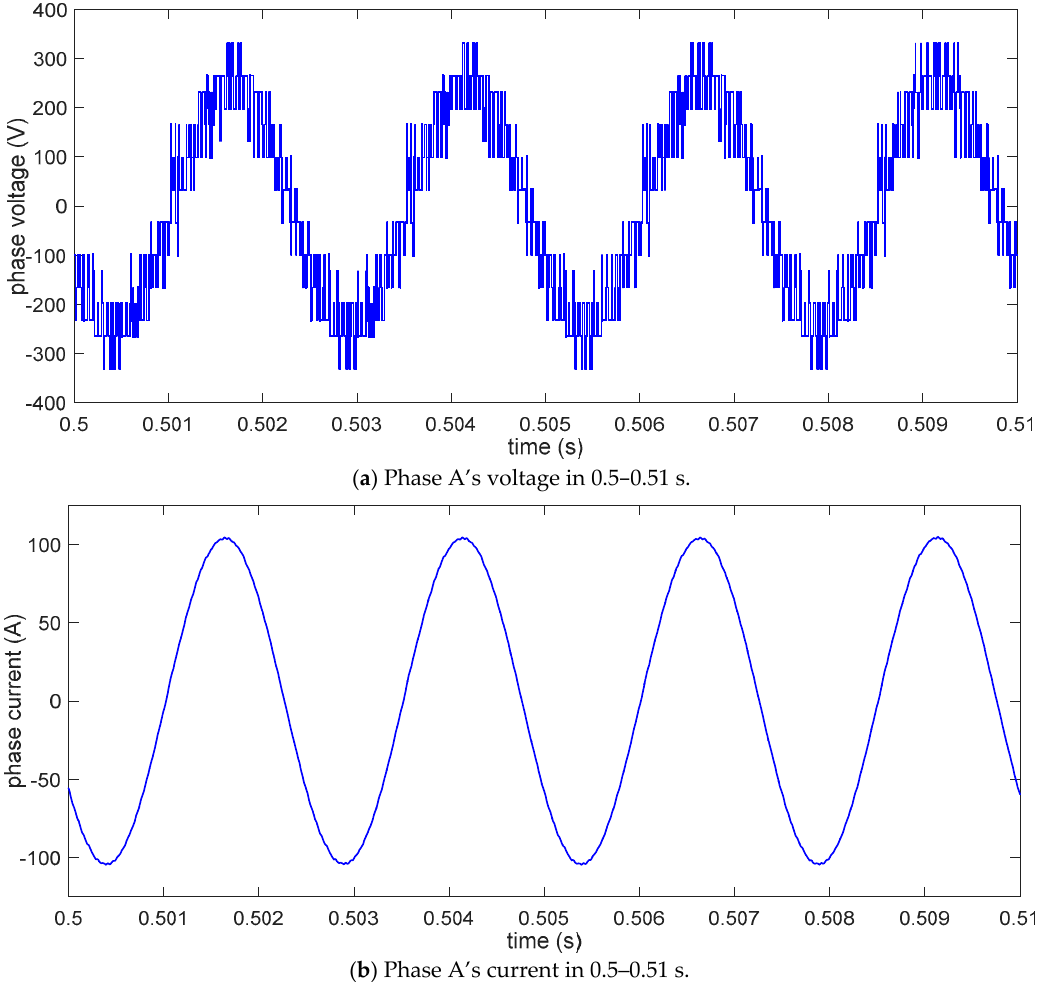
Figure 12. Local curves of phase A’s voltage and current and harmonic component.